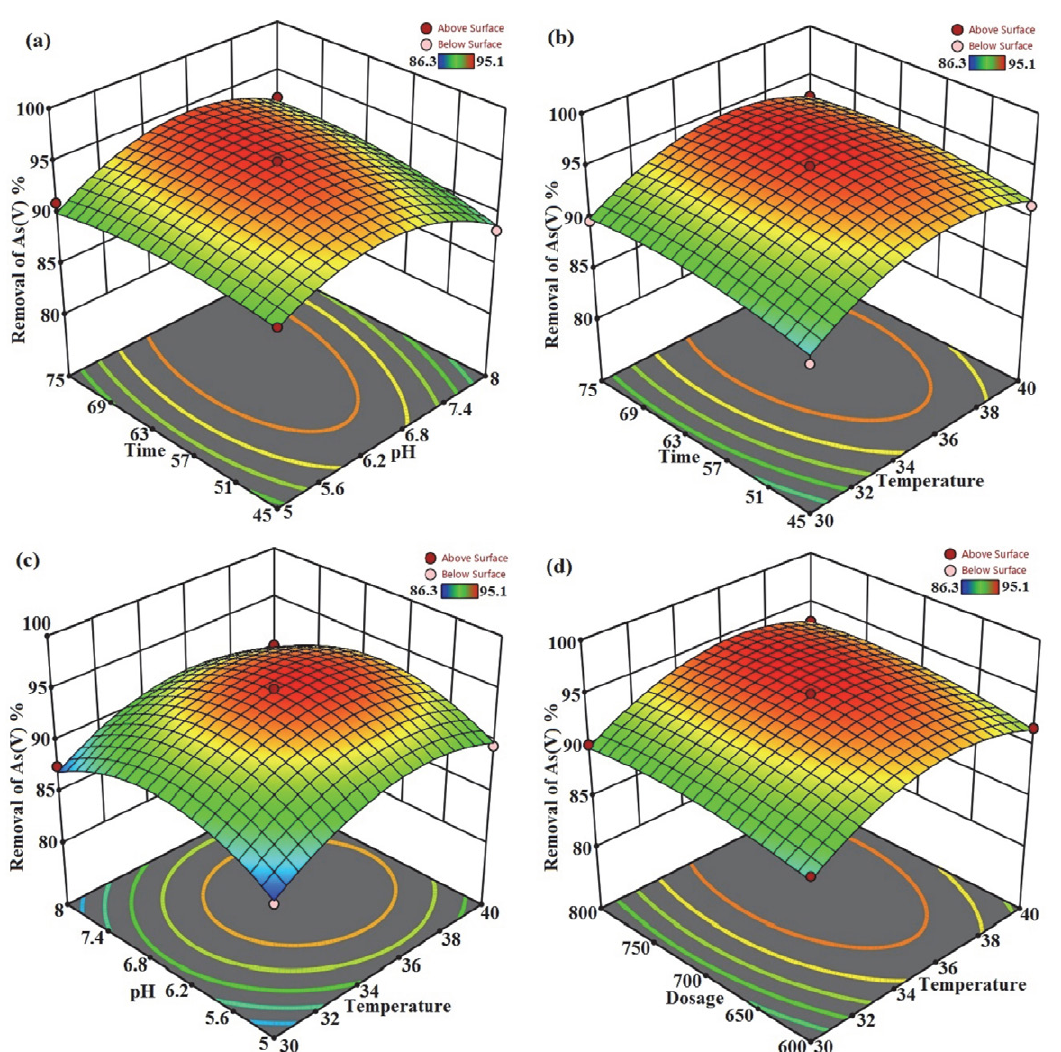
Fig. 3. 3D surface plot of interaction effects between variables of a) time vs pH b) time vs temperature c) pH vs temperature and d) adsorbent dosage vs temperature on As(V)